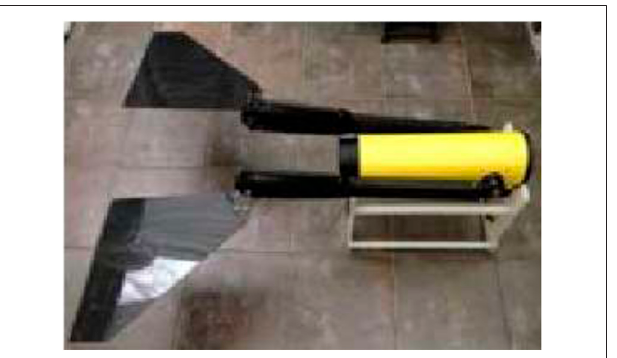
FIGURE 2 | Wave energy recovery system